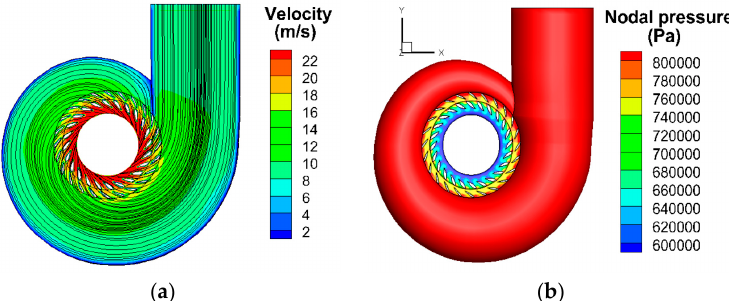
Figure 5. Distribution of velocity, streamline, and pressure in the spiral casing and vaneless region. ( a ) Velocity and streamlines distribution, ( b ) pressure contour.